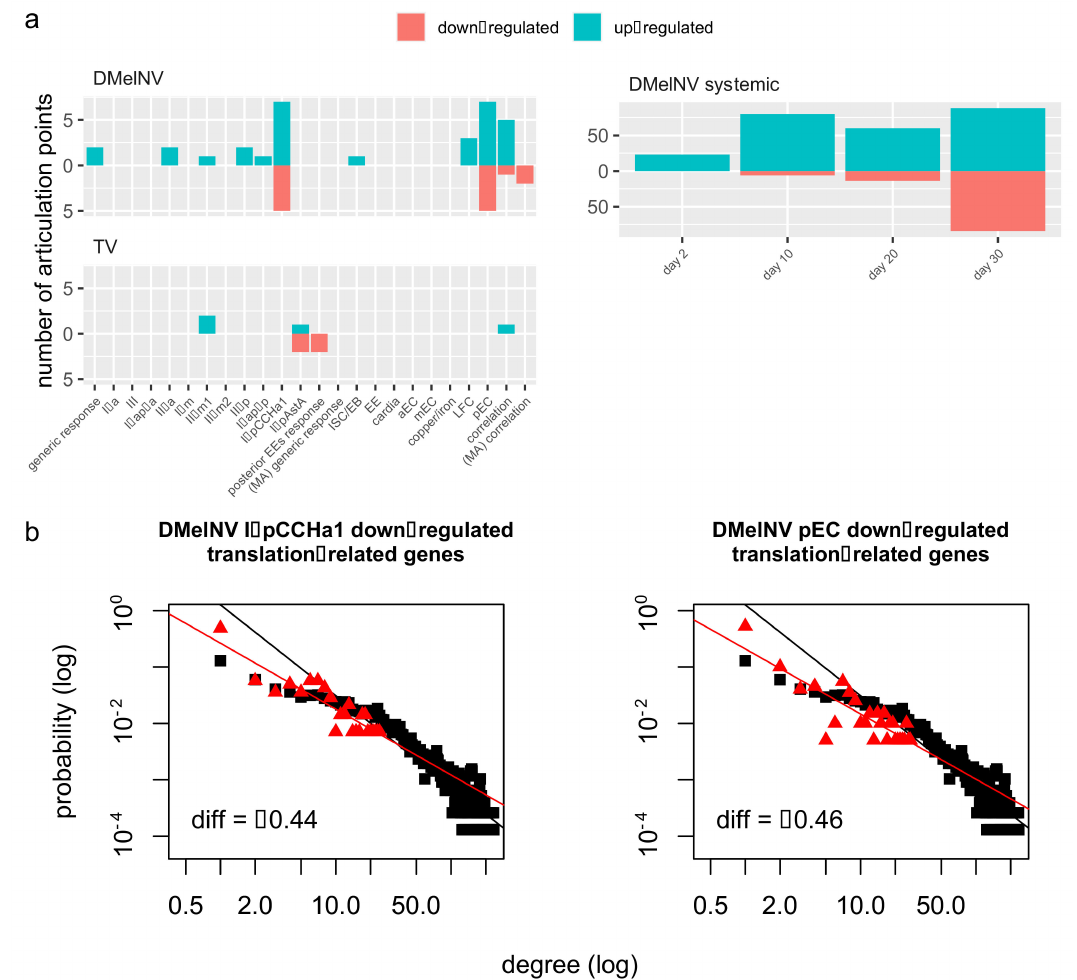
Figure 7. Perturbation of bottlenecks and hubs in the Drosophila interactome. ( a ) Number of articulation points found in each list of DEGs. ( b ) Down-regulated translation-related genes in response to DMelNV infection compose hubs in the drosophila interactome. Log-degree distributions of the whole D. melanogaster interactome (black) and subnetworks constructed with translation-related genes that are down-regulated in DMelNV-infected I-p CCHa1 and pEC cell subtypes (red). The slope of the regression lines represents the critical exponent of the power-law, γ